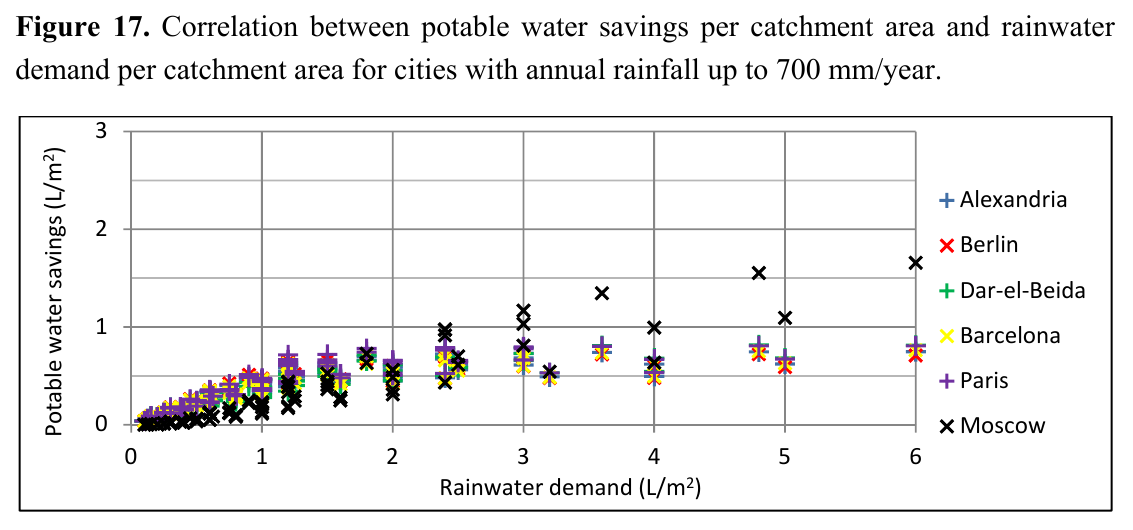
Figure 18. Correlation between potable water savings per catchment area and rainwater demand per catchment area for cities with annual rainfall ranging from 701 mm/year to 1500 mm/year.